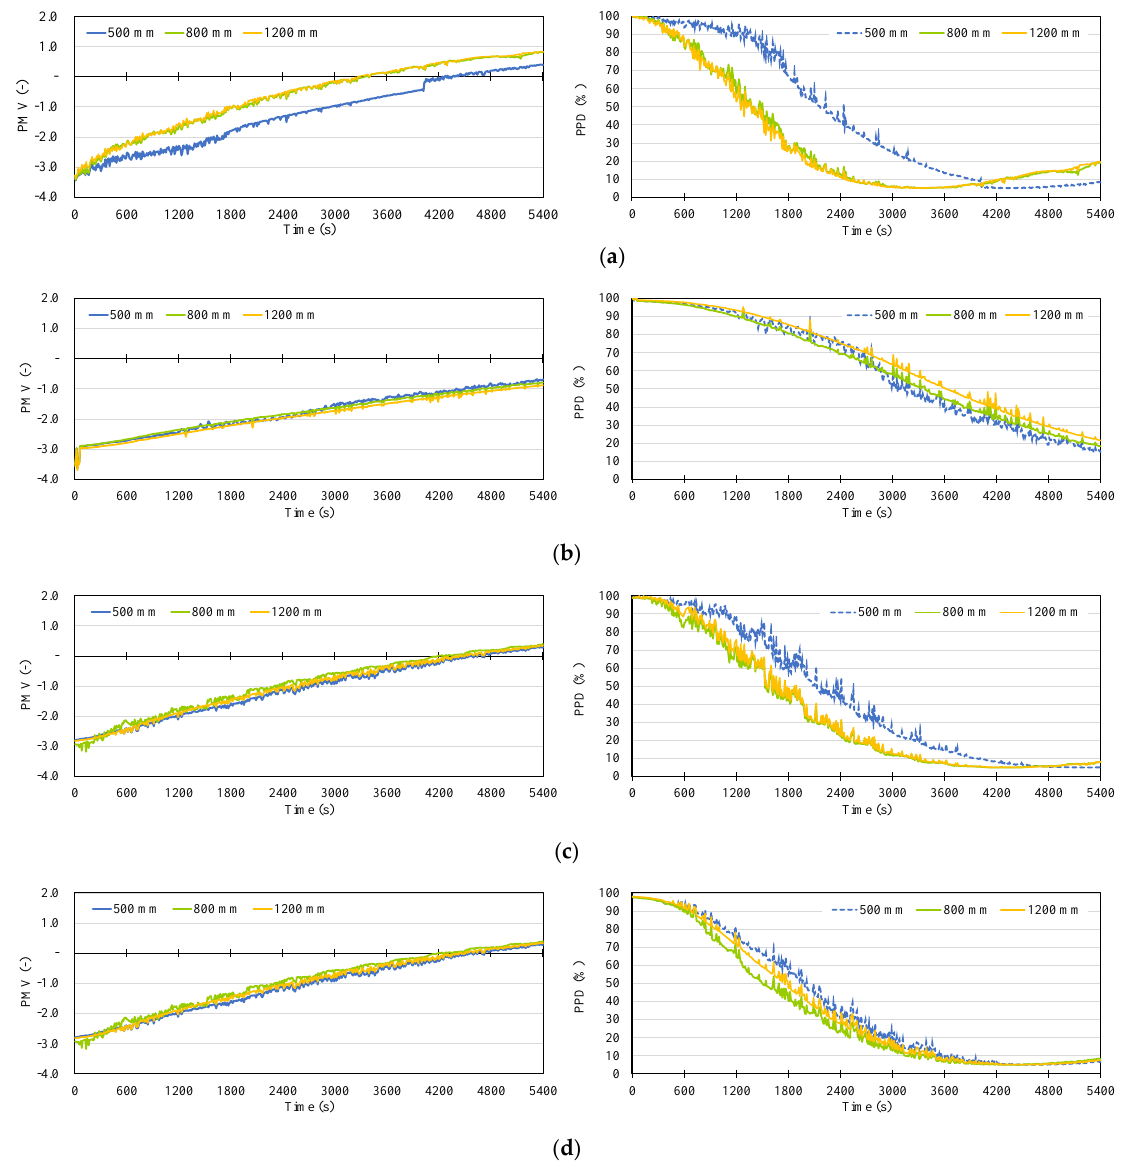
Figure 11. Evaluated PMV and PPD values. ( a ) Mode 1 results for PMV and PPD; ( b ) Mode 2 results for PMV and PPD; ( c ) Mode 3 results for PMV and PPD; ( d ) Mode 4 results for PMV and PPD.